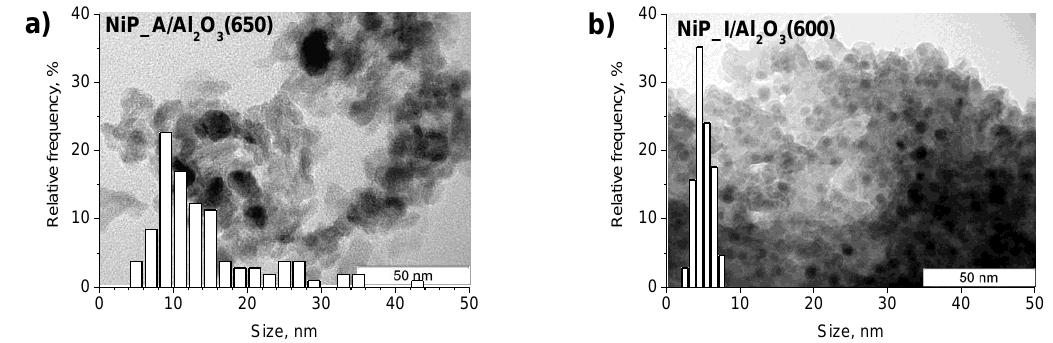
Figure 4. TEM images of Ni x P y /γ-Al 2 O 3 catalysts prepared from different precursors: ( a ) NiP_A/Al 2 O 3 (650) and ( b ) NiP_I/Al 2 O 3 (600).